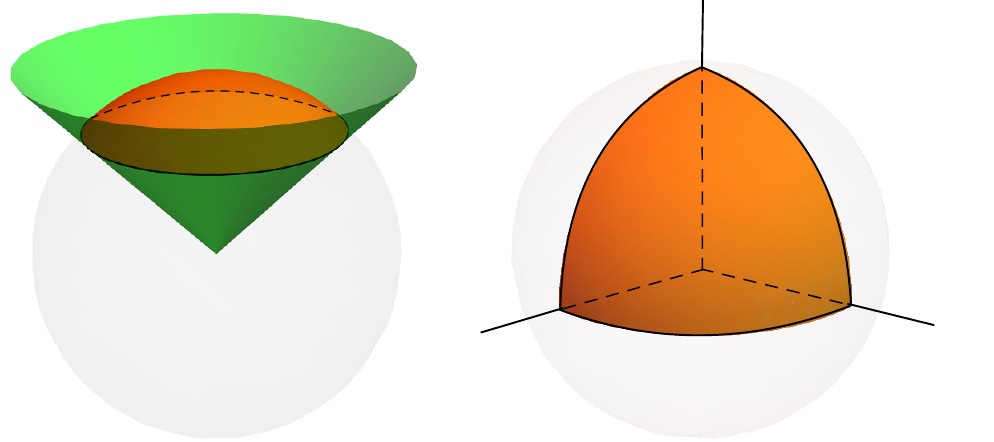
Figure 1 . (Left) We plot the S 1 resulting from the intersection of the conical region de(cid:12)ned by (cid:18) 2 [ (cid:0) (cid:10) ; (cid:10)], (cid:30) 2 [0 ; 2 (cid:25) ) with a unit S 2 in the equator of S 3 . The boundary conditions are implemented as we approach the orange region in the equator of S 3 from above and below in the additional angular coordinate (not shown in the (cid:12)gure). (Right) We plot the intersection of a trihedral corner region of right opening angles with the unit S 2 . In this case, (cid:13) is the union of three quarters of great circles, for which the extrinsic curvature vanishes, k =